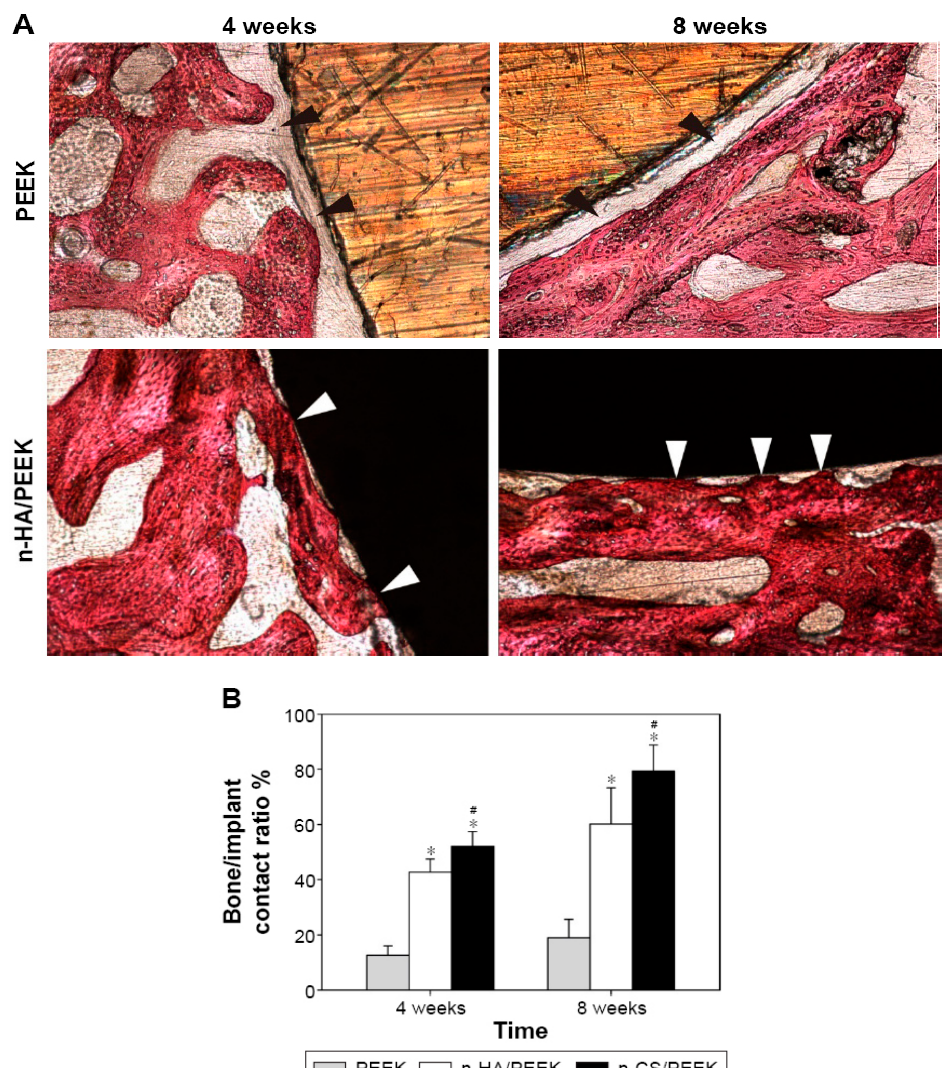
Figure 18. Histological observation of osseointegration of pure PEEK and PEEK/40wt% nHA samples after 4 and 8 weeks implantation into full-thickness cranial defects of rabbits. ( A ) Histological images. The black arrows indicate fibrous connective tissue, and white arrows indicate bone contact. ( B ) Comparison of percentage of bone/implant contact among PEEK, PEEK/40 wt% nHA and PEEK/40 wt% n -CS implants. ∗ denotes a significant difference compared with PEEK ( p < 0.01), and # indicates a difference compared with PEEK/40wt% nHA ( p < 0.05). Reproduced from [163] with permission of